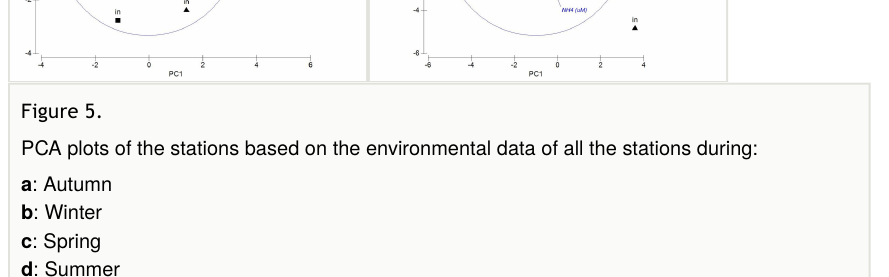
over all seasons (Fig. 6). The results did show signi fi cant grouping of the stations except following a seasonal pattern: pseudo-F=4.952, p<0.05 for Mazoma lagoon; pseudo- F=4.802, p<0.05 for Logarou lagoon; pseudo-F=3.647, p<0.05 for Tsopeli lagoon; pseudo-